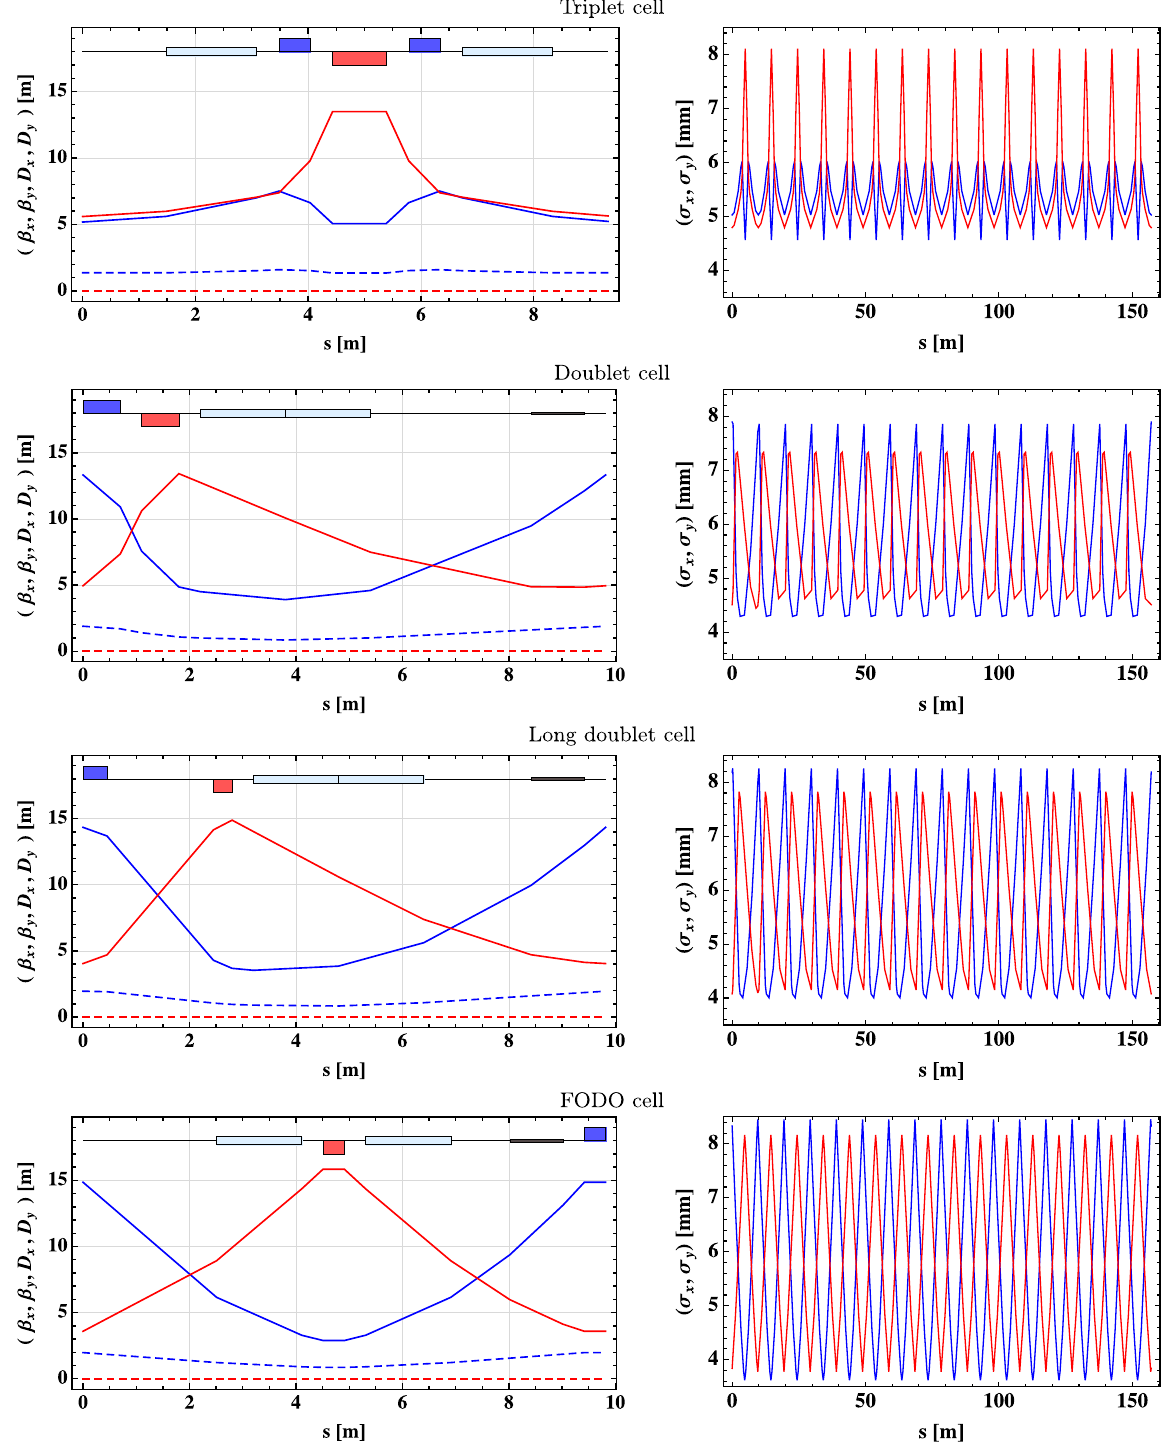
FIG. 4. Optics (left) of the different lattice cells and one rms beam envelope of the complete lattice (right). From top to bottom: triplet, doublet, long doublet and FODO. The beam envelope has been calculated using the design transverse normalized rms emittance of 2 . 5 μ m and the rms momentum spread corresponding to the design longitudinal emittance of 2.8